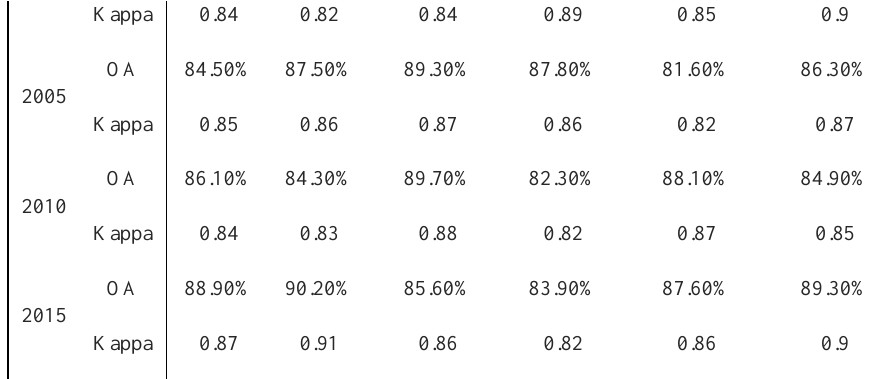
Table 3. Classification accuracy evaluation